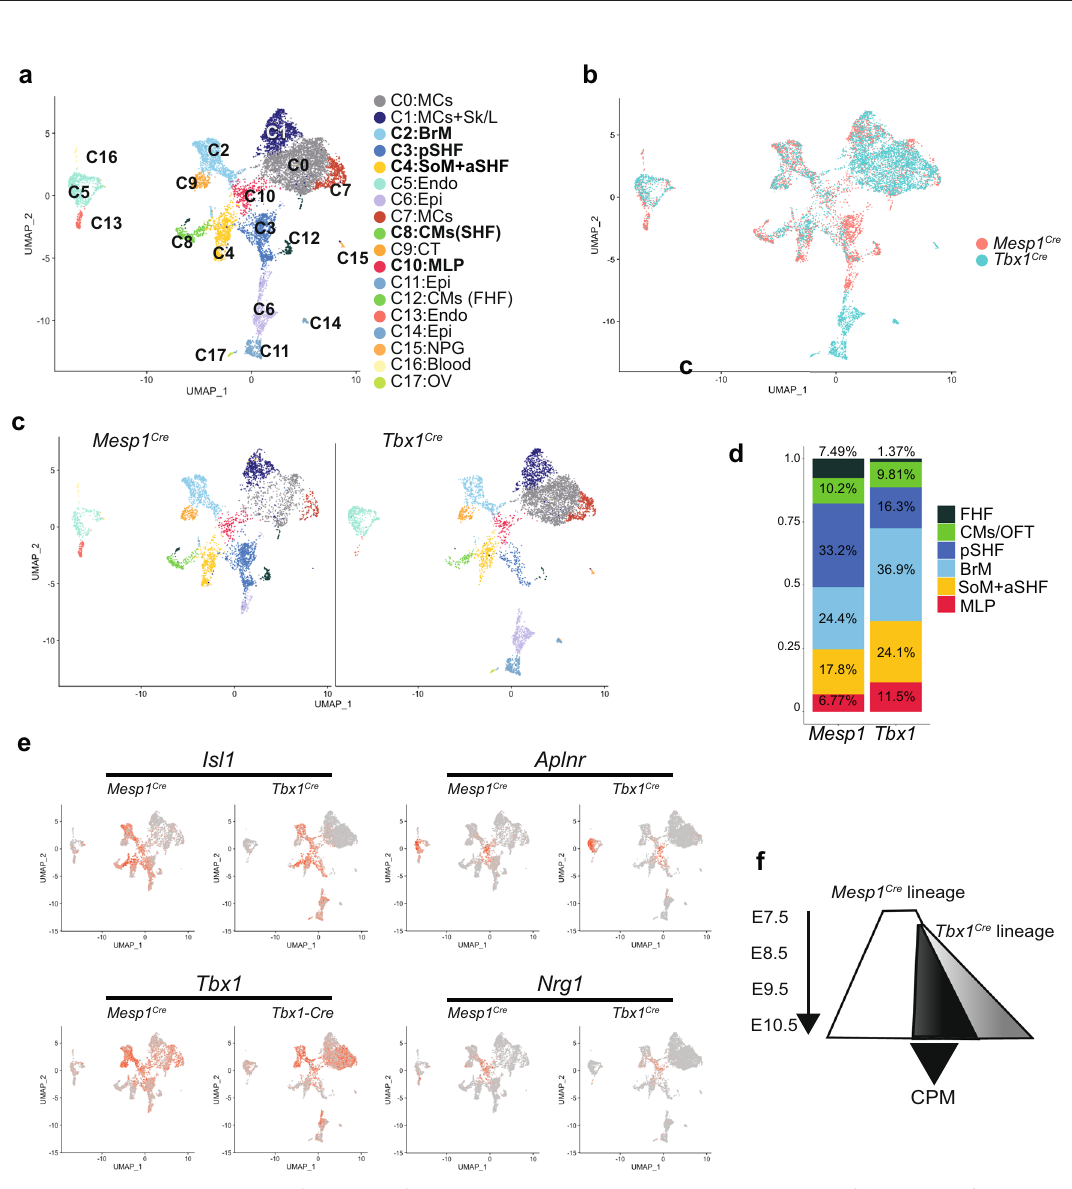
Fig. 4 CPM clusters were found in both Mesp1 Cre and Tbx1 Cre lineages. a UMAP plot of integrated data of Mesp1 Cre/ + and Tbx1 Cre/ + scRNA-seq data at E9.5, colored by cluster. CPM clusters are shown in bold font. b UMAP plot colored by samples ( Mesp1 Cre , coral; Tbx1 Cre , aqua). c UMAP plots, colored by cluster, separated by samples. d The ratio of cell populations of CPM lineages in Mesp1 Cre/ + and Tbx1 Cre/ + scRNA-seq data. A two proportion Z test was performed in each cluster with 95% con fi dence interval (MLP: P value = 2.27e-13; pSHF: P value = 2.2e-16; SoM/aSHF: P value = 2.72e-5; OFT + CMs: P value = 0.70). e UMAP plots for showing MLP marker genes, separated by samples. The color spectrum from gray to red indicates expression level from low to high. f Intersection of scRNA-seq data between the two Mesp1 Cre and Tbx1 Cre populations. Black triangle shows genes shared in both populations and this represents the CPM. Genes shared in both populations have been used for further study in this report. Genes expressed in one versus the other have not been further